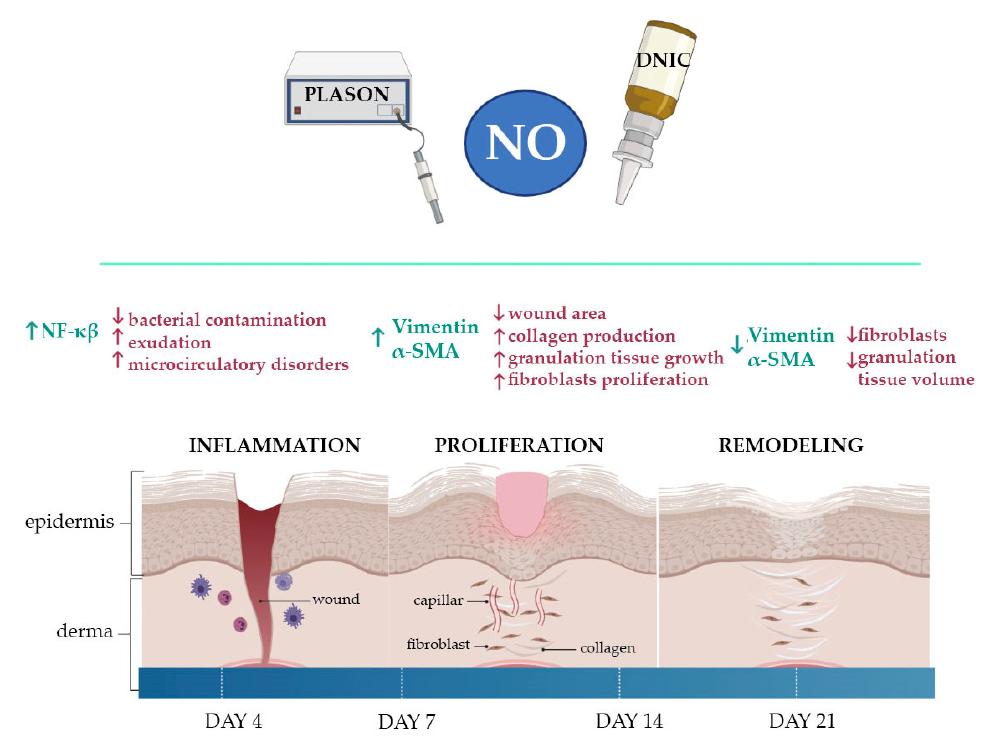
Figure 19. Nitric oxide’s effects in wound healing (created using Biorender.com).